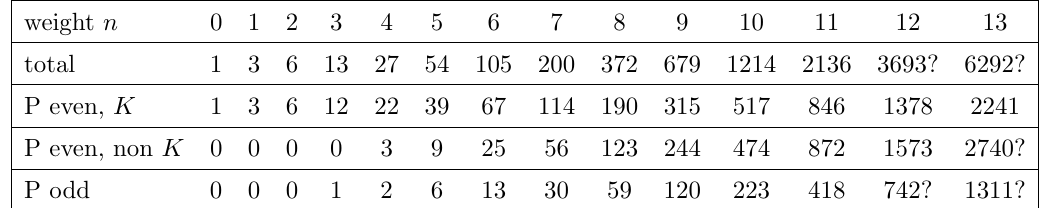
Table 11 . The dimension of the extended Steinmann hexagon function space H hex , graded by parity and by K vs. non- K in the P-even case. Beyond weight 7, the coproducts of known amplitudes do not saturate all of the functions, and so the numbers may be further reduced eventually. At weights 12 and 13, the numbers may be o(cid:11) by one or